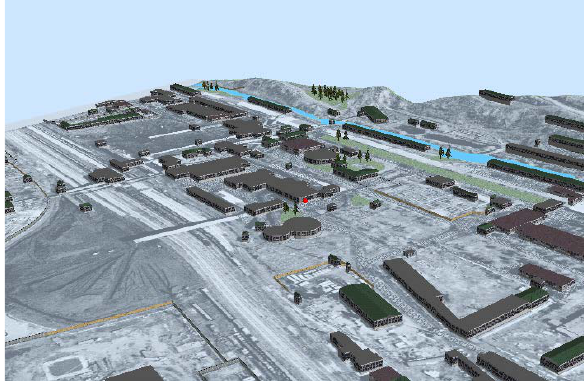
Figure 1. A 3D video